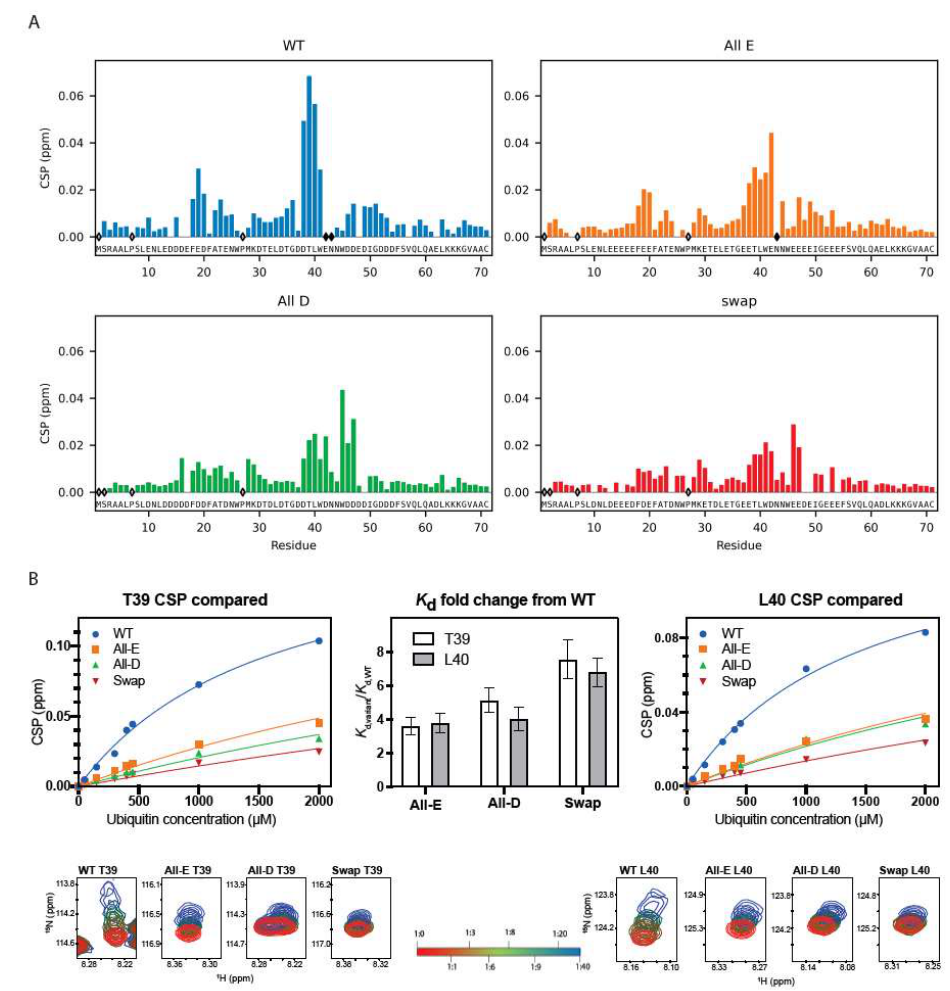
Figure 4. Ubiquitin binding ability is supported by both glutamate and aspartate. ( A ) CSP for Dss1 WT and Glu/Asp variants (each at 50 µ M concentration) binding to a 40 times molar excess of ubiquitin (2 mM). Empty diamonds indicate non-assigned residues, and filled diamonds indicate disappearance of peaks upon ubiquitin addition. ( B ) CSP of Dss1 WT and Glu/Asp variants for residue T39 (left) and L40 (right) as a function of ubiquitin concentration, fitted to derive the relative affinities for each variant. The middle bar plot shows the fold-change in affinity for the three variants (compared to WT Dss1) derived from the fits to either T39 or L40. The bottom figures show the HSQC peaks for T39 (left) and L40 (right) during ubiquitin titration (from 1:1 to 1:40) indicated by the red-green-blue color change, respectively.